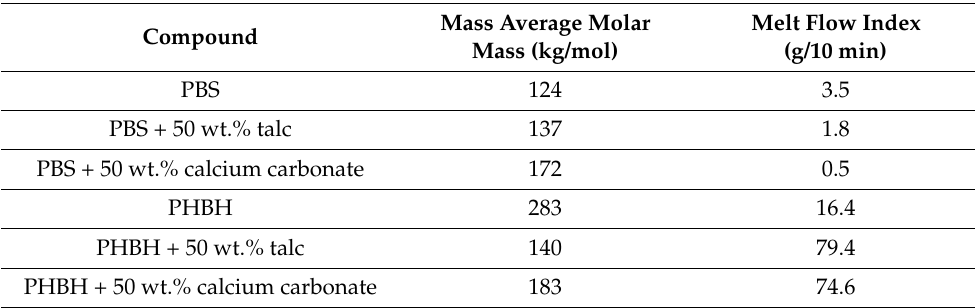
Table 1. Overview of mass average molar mass and melt flow index values of PBS and PHBH with 50 wt.% talc and calcium carbonate